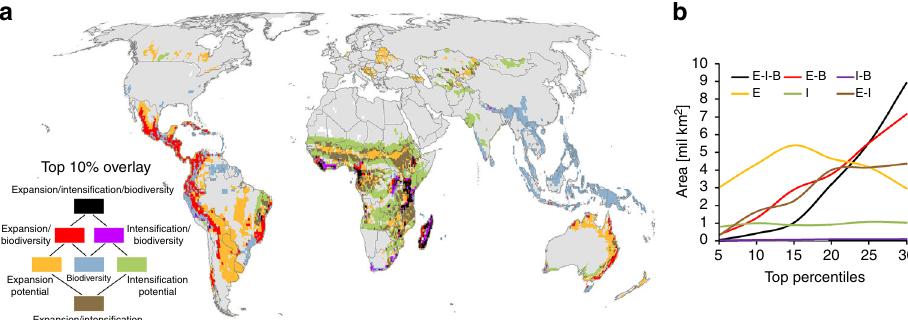
Fig. 5 Quantile overlay of expansion potential, intensi fi cation potential and endemism richness. While a shows the 10th percentile, b shows the sensitivity of the overlay based on selected thresholds between 5 and 30% (see Supplementary Fig. 18 for maps of the different thresholds). The overlay analysis was performed at 55 km resolution of an equal-area grid. The red areas highlight the hottest hotspots, where high biodiversity may be particularly threatened by future cropland expansion. The purple areas highlight the hottest hotspots, where high biodiversity may be particularly affected by future cropland intensi fi cation. The black areas pinpoint places where high biodiversity is particularly threatened by both agricultural scenarios simultaneously. The orange, green and blue colours indicate regions with the top 10% of expansion potential, intensi fi cation potential and biodiversity that do not overlap with any other top 10% of data. The brown areas indicate regions where the top percentile of expansion and intensi fi cation potential overlap without overlapping the top percentile areas of biodiversity. In b , the same colours are used, abbreviating expansion ( E ), intensi fi cation ( I ) and biodiversity (